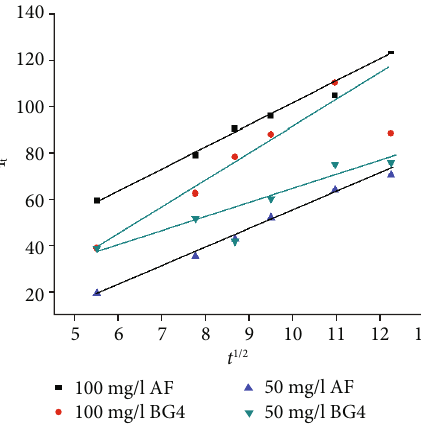
Figure 15: Intraparticle di ff usion model for adsorption of basic green 4 dye onto HUAC.